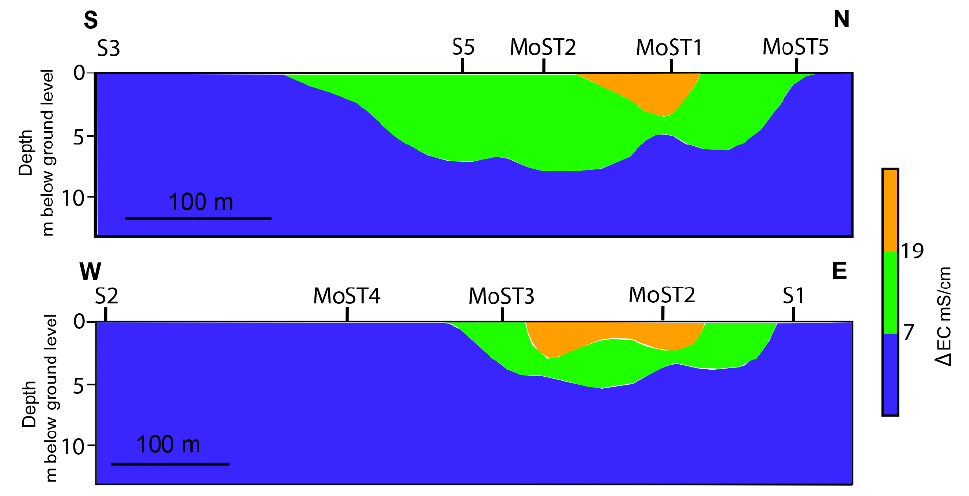
Figure 16. Interpolation of the EC difference between best and worst mitigation conditions in the N-S and W-E section shown in Figure 15. The location of the monitoring wells is reported.